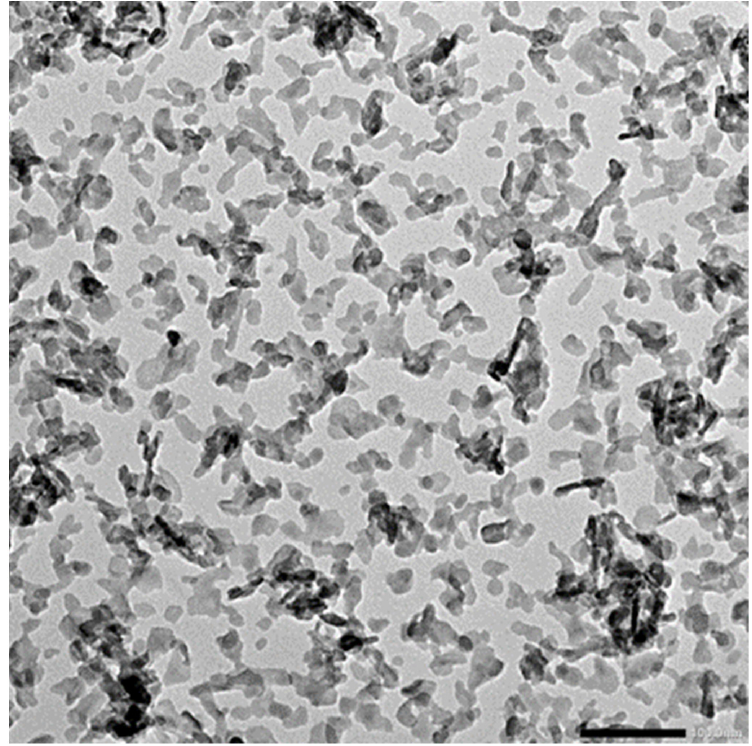
Figure 2. Transmission electron microscopy (TEM) image of synthetic hydroxyapatite nanoparticles.